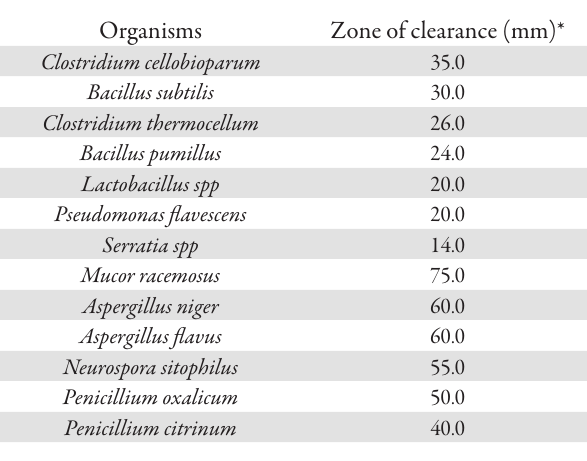
Tab. 4. Screening for cellulase